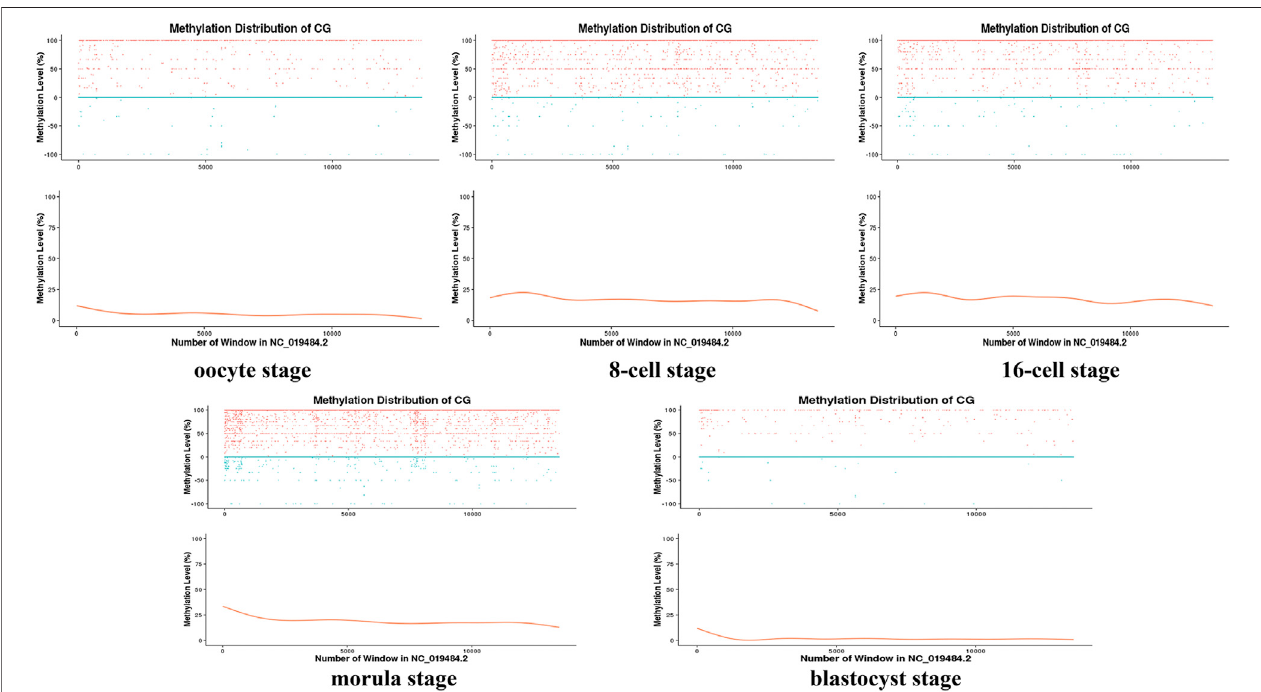
FIGURE2| DistributionmapofthemethylationleveloftheXchromosomeatdifferentstages.Theslidingwindowmethod(10 kbp)wasusedtocalculatethelevelof methylationin each chromosome window (distinguishingbetweenpositive andnegativestrands) todelineate themethylation level pattern onasingle chromosome.The horizontal axis represents the window number (i.e., the length of the chromosome) in the X chromosome (NC_019484.2); for the vertical axis, the upper part is the methylation level of each window on the positive and negative strands (scatter plot), and the lower part is the level of methylation (curve) that does not distinguish between the positive and negative strands.